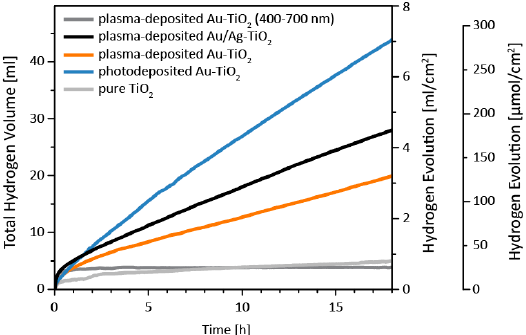
Figure 7. Hydrogen evolution of all samples from a methanol/water mixture. Conditions: 80 mL Hydrogen evolution of all samples from a methanol/water mixture. MeOH/H 2 O (1/1, v/v ), Lumatec Hg-light source equipped with a 320–500 nm filter, 7.2 W output, 25